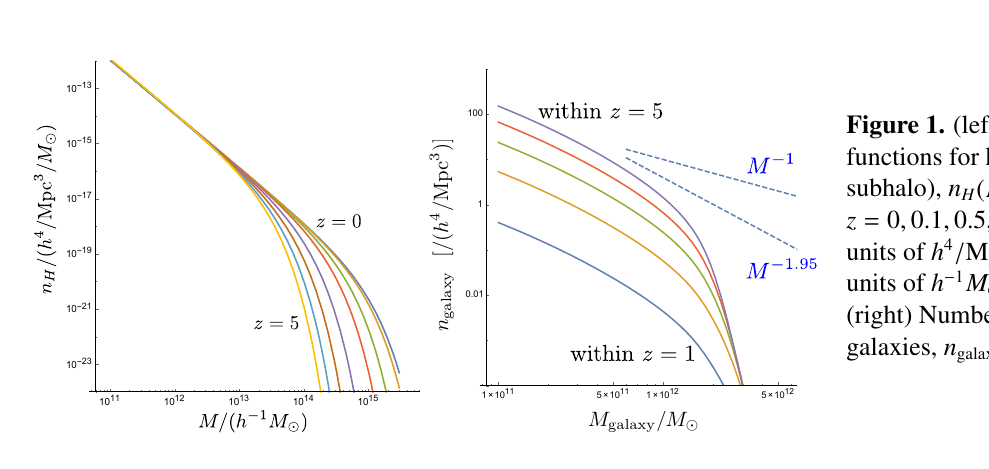
Figure 1. (left) Global mass functions for halos (halo and subhalo), n H ( M ), for z = 0 , 0 . 1 , 0 . 5 , 2 , 4 , 5. n M ) is in H ( units of h 4 / Mpc 3 / M . M is in ⊙ units of h − 1 M , with h = 0 . 7. ⊙ (right) Number density of galaxies, n ( M ). galaxy